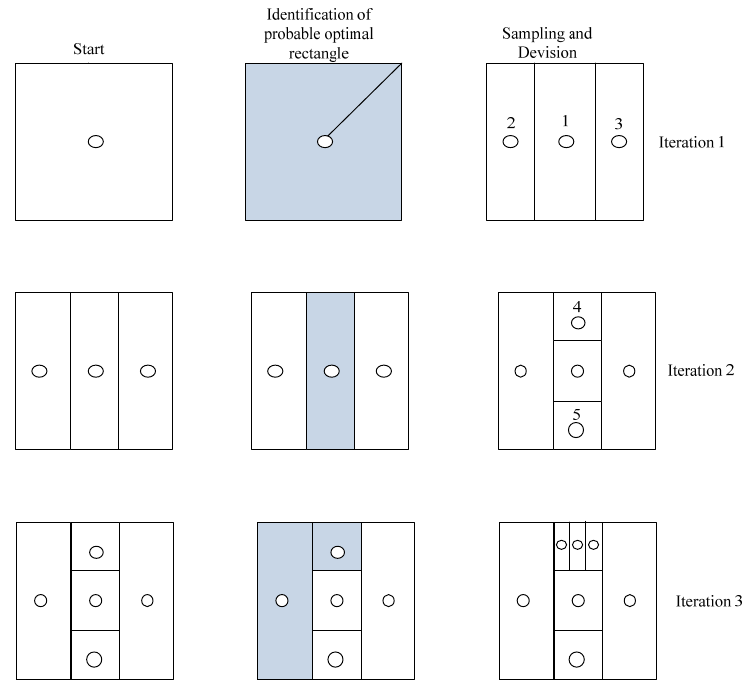
Figure 4. Hyper-rectangle formation in the DIRECT algorithm.